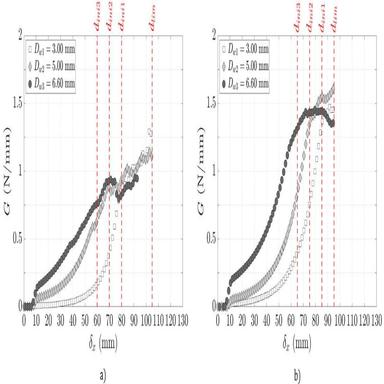
ERR-displacement curves for (a) rigid and (b) flexible bonded joints tested with different wedge thicknesses. Distances dini1, dini2 and dini3 correspond to wedge diameters Dw1, Dw2 and Dw3, respectively.